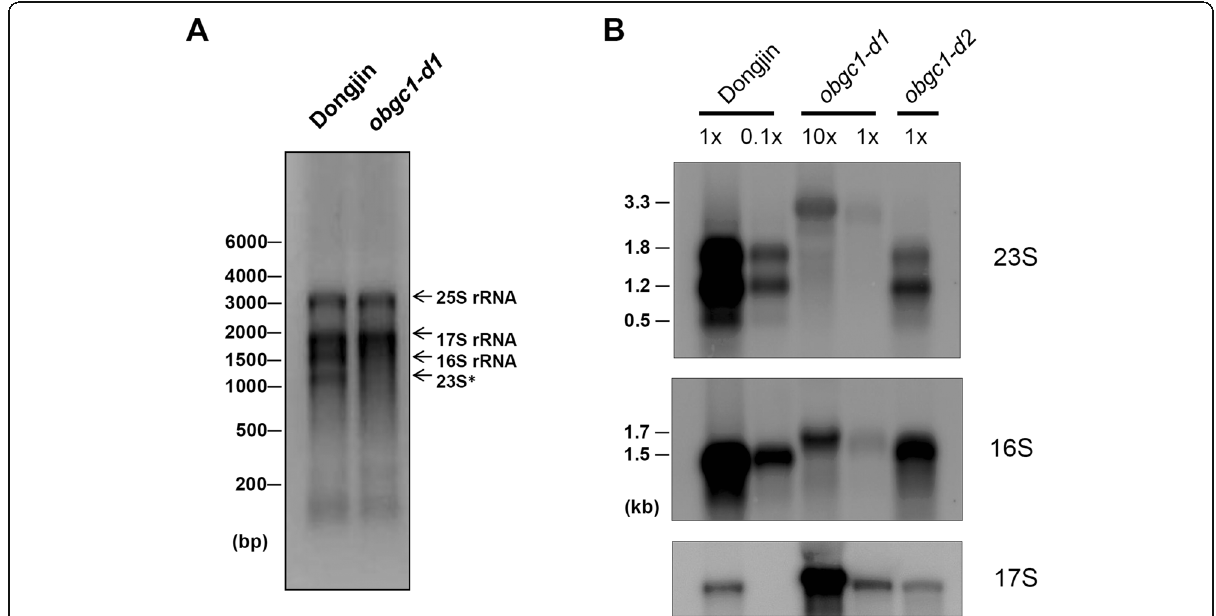
Fig. 9 Effect of obgc1 mutation on the accumulation of plastid precursor rRNA. A Abundance of rRNAs. One microgram of total RNAs from 10- day-old wild-type (Dongjin) and obgc1-d1 seedlings was separated on a denaturing gel, and then stained with EtBr (ethidium bromide). “ 23S* ” (approximate 1.2 kb) is the breakdown product of chloroplast 23S rRNA. B obgc1-d mutation causes the accumulation of precursor 23S or 16S rRNAs. Northern blot analyses of plastid rRNAs were performed using total RNAs (1x, 1 μ g; 0.1x, 0.1 μ g; 10x, 10 μ g). Blots were probed with gene- specific sequences for 16S/23S rRNAs. Cytosolic 17S rRNA was used as a loading